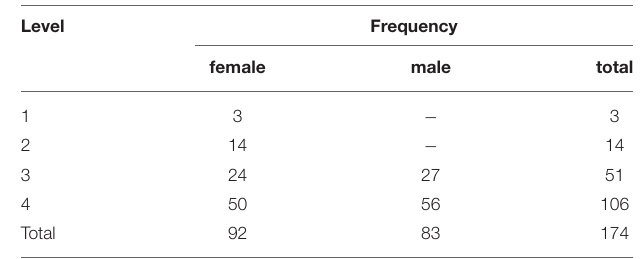
TABLE 4 | Participant characteristics by group and level of education in Experiment